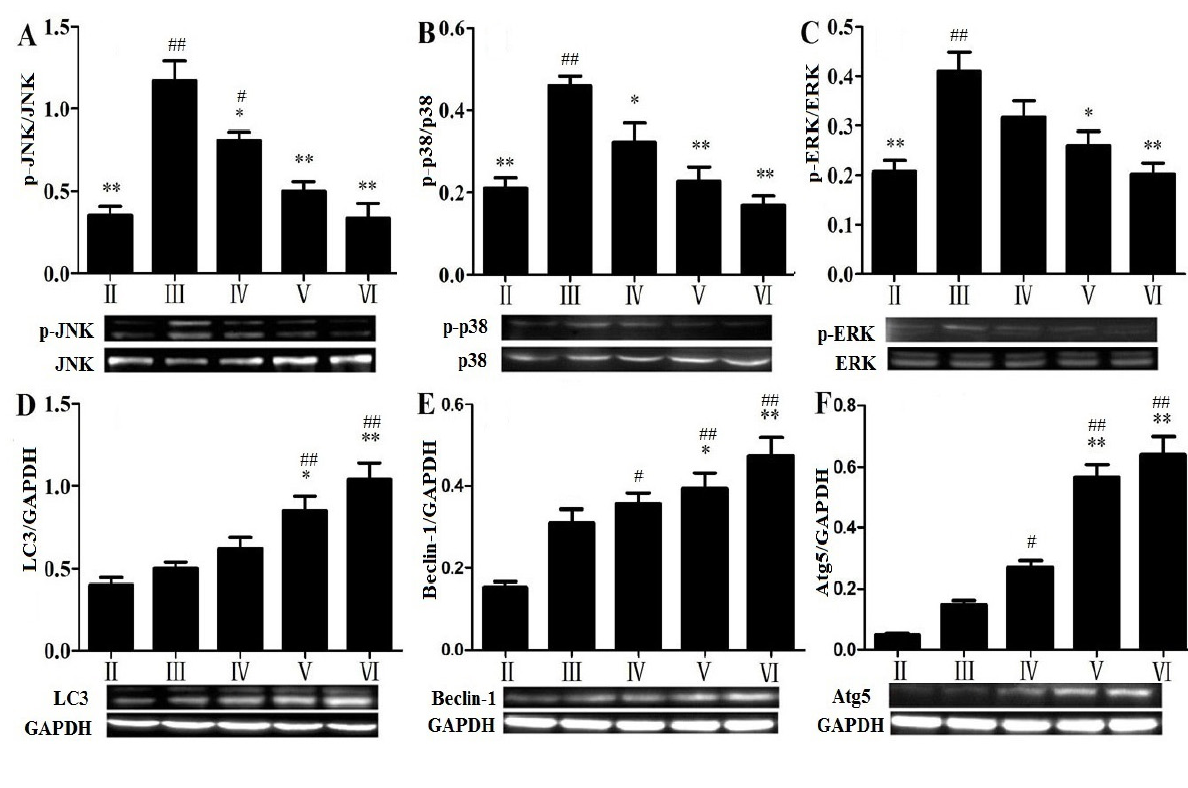
Figure 7. Effects of RLTS on the protein expressions of p-JNK ( A ), p-p38 ( B ), p-ERK ( C ), LC3 ( D ), Beclin-1 ( E ) and Atg5 ( F ). Values are expressed as mean ± SD ( n =